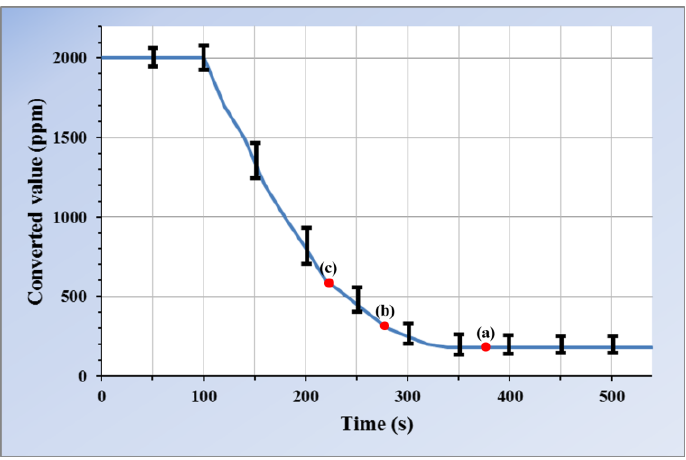
Figure 4. Example of preheating